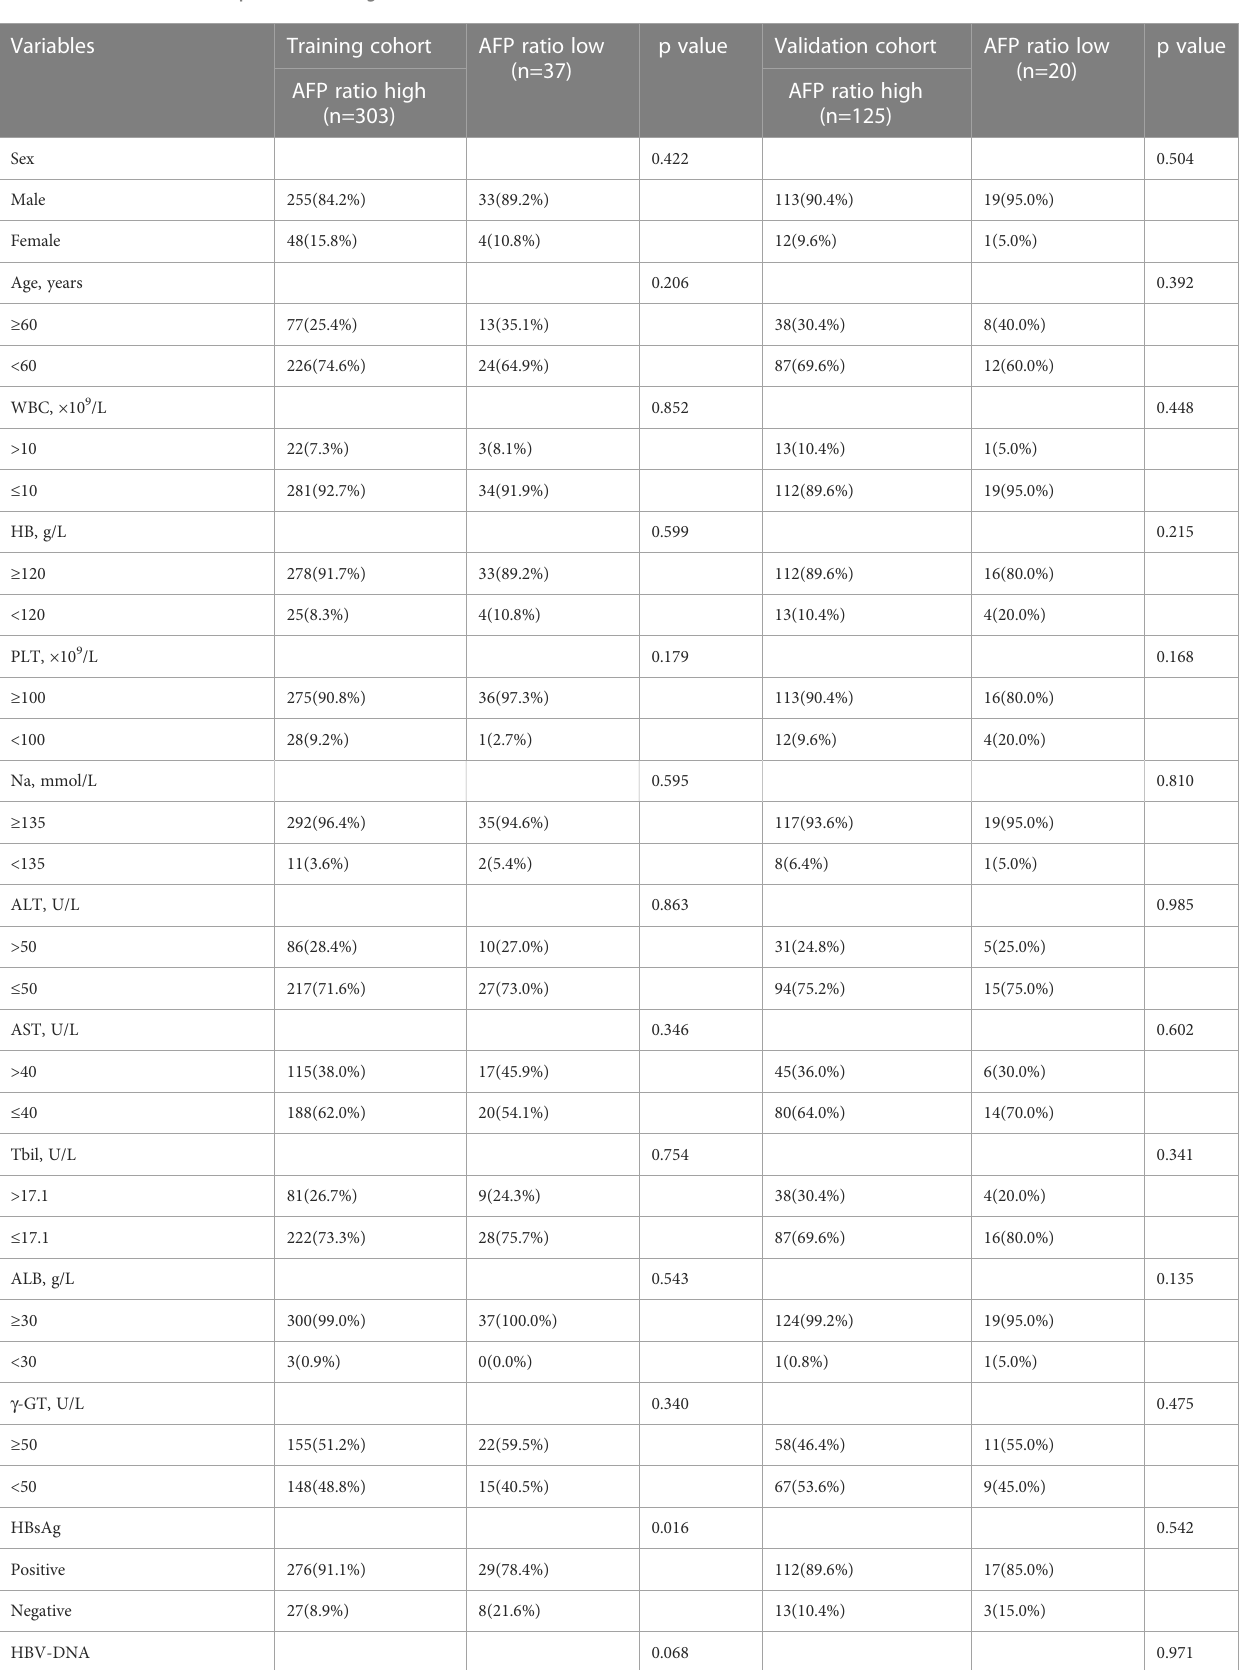
TABLE 2 Clinical features of patients with high and low AFP ratios in two